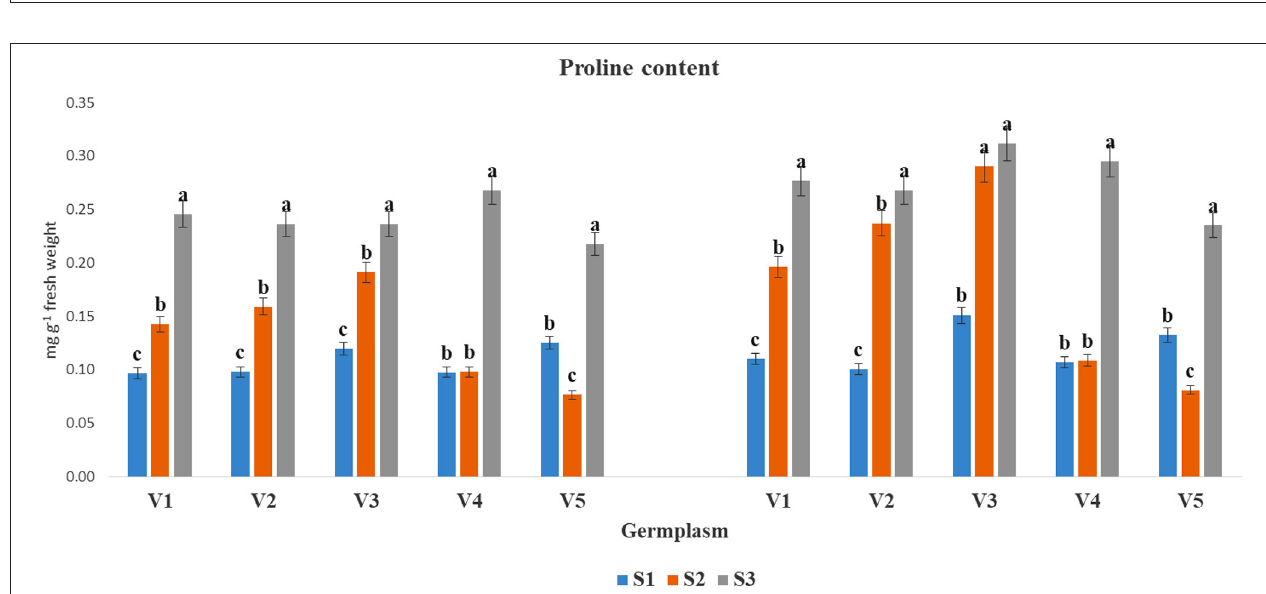
FIGURE 4 | The PC (mg g − 1 fresh weight) at mid-flowering stage in the top leaf of mustard varieties sown at three different dates during rabi 2017–2018 and 2018–2019. Different date of sowing represented as S1 timely sown (30 October), S2 late sown (15 November) and S3 very late sown (30 November); Varieties symbolize with: V1, PM 25; V2, PM 26; V3, BPR-541-4; V4, RH-406; and V5, Urvashi, respectively. The mean value ± p ≤ 0.05 error bar data were presented in the figure and different alphabetical letters indicate the significant difference for each variety under different date of sowing ( p ≤ 0.05).